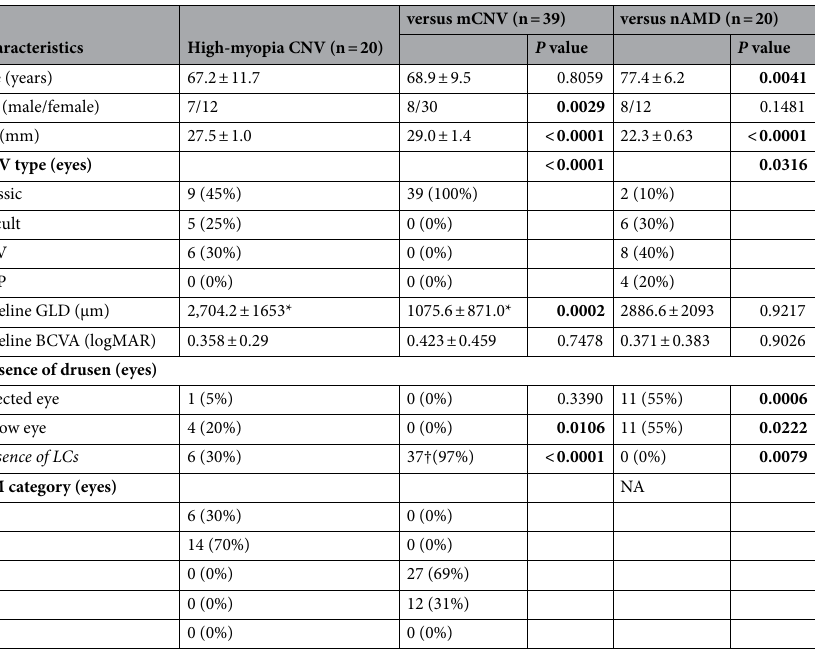
Table 1. Comparison of patient background between high-myopia CNV versus mCNV and versus nAMD. The values are expressed as the mean ± standard deviation. Significant values are in bold. AL axial length, RAP retinal angiomatous proliferation, logMAR , logarithm of the minimum angle of resolution. *Within the number of cases excluding one eye that did not undergo fluorescein angiography. † Within the number of cases excluding one eye that did not undergo